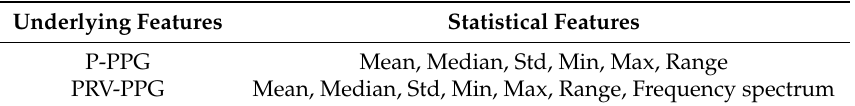
Table 4. Features extracted from PPG